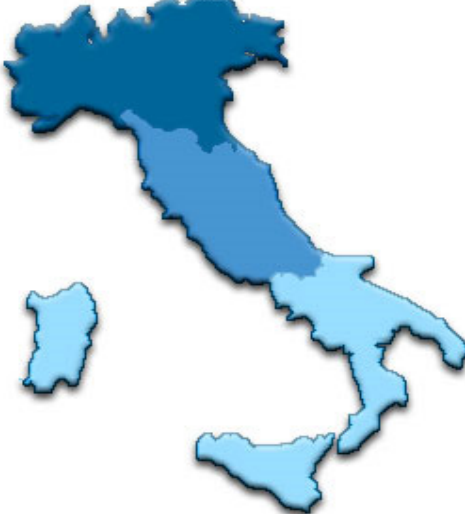
Figure 1. Division of Italy in geographical areas: North (dark blue), Center (blue) and South (light blue).